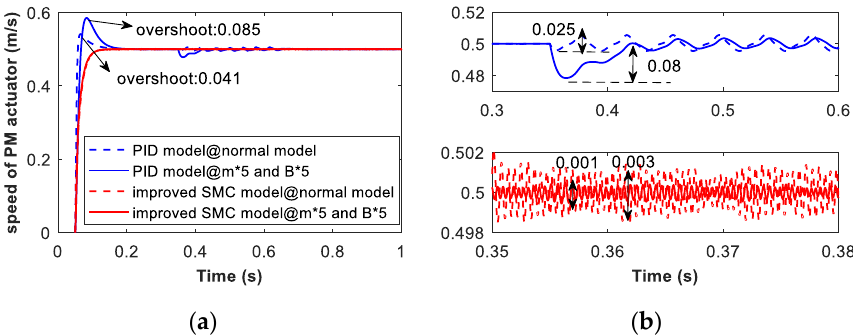
Figure 8. Speed curve of segmented PMLSM with parameter perturbation and di ff erent models, ( a ) speed curves and ( b ) disturbance